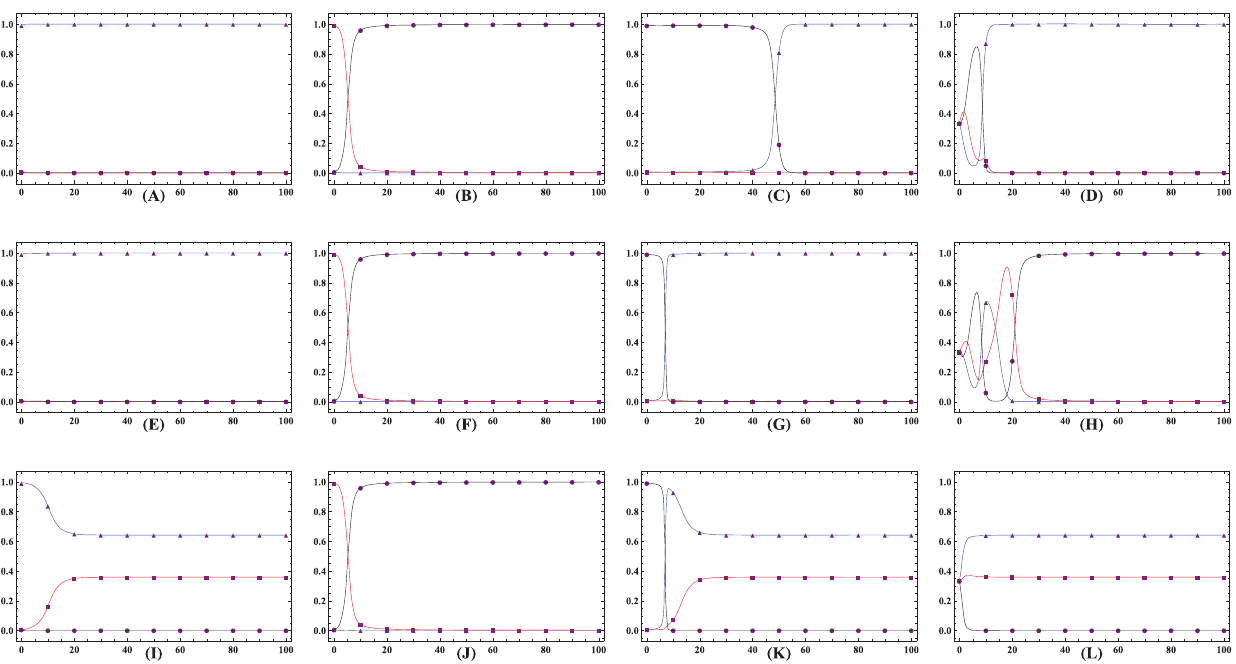
Figure 3. Population dynamics whenever cooperators defectors, and loners compete to survive. The lines embedded with solid triangle, square, and circle represent the evolutionary trajectories of cooperators, defectors and loners, respectively. For r ~ 6 , irrespective of the risk removal patterns, loners becomes the unique victor for the population starting with defectors accounting for the absolute majority. The abundance of loners or cooperators invariably leads to the establishment of cooperators in the inverse sigmoidally and linearly dependent patterns, while leads to the coexistence of cooperators and defectors in the sigmoidally-dependent pattern. Starting with the point of cooperators, defectors, and loners, the population navigates to extremely different equilibrium states under the three risk removal patterns. Parameters N ~ 10 , r ~ 6 . Upper row m ~{ 0 : 4 , middle row m ~ 0 , and low row m ~ 10 .